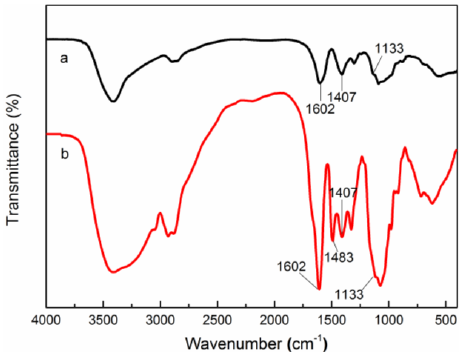
Figure 2. Fourier transform infrared (FT-IR) spectra of ( a ) carboxymethyl chitosan (CMC) and ( b ) Quaternized carboxymethyl chitosan